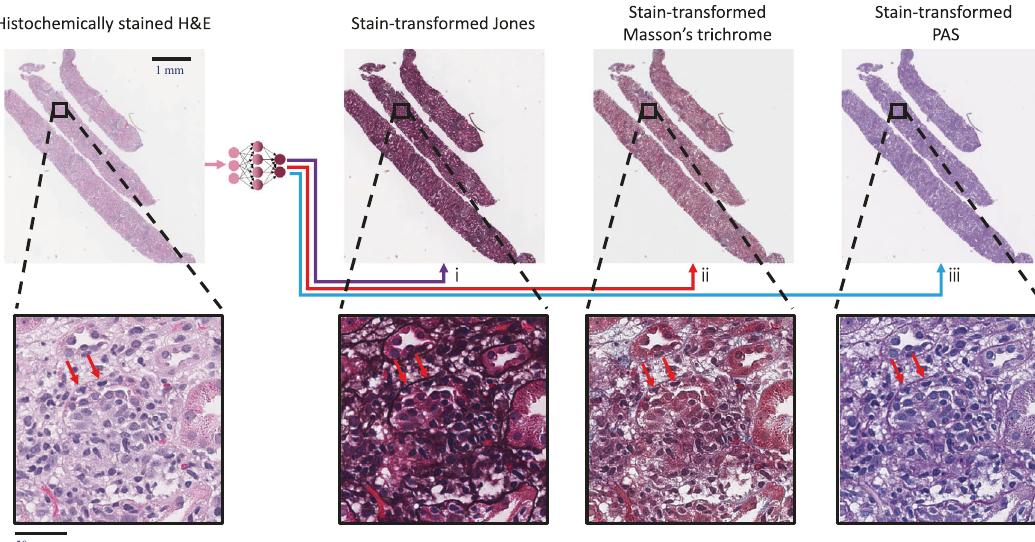
Fig. 5 Examples of improved diagnoses fostered by the stain-transformed special stains. We report here WSIs that are generated using the stain transformation technique. In this case, the addition of the computationally generated special stains improved all three of the diagnoses made by the pathologists. The red arrows point to a region, where the special stains help highlight in fl ammatory cells within the tubule, otherwise, the boundary of the tubules cannot be seen with the H&E stain only. (i) Generation of JMS. (ii) Generation of MT. (iii) Generation of PAS. A total of 58 cases were viewed by three pathologists to perform the statistical